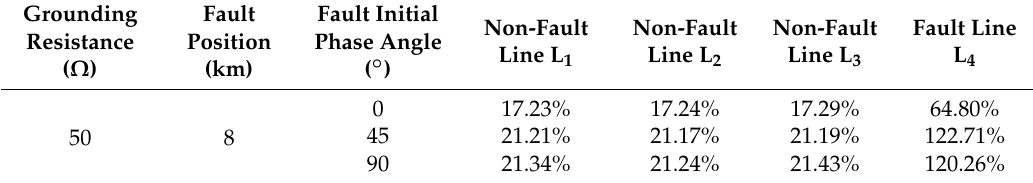
Table 2. The percentage of the DC component in SPG faults under different initial phase angles. Grounding